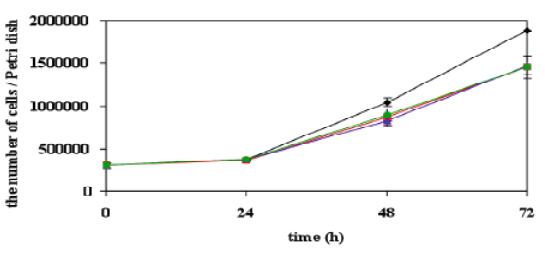
Figure 4. Growth curve of NIH-3T3 cells cultured with biomaterials: ♦ - C; ● – FHA; ▲ - FA; ■ – HA.